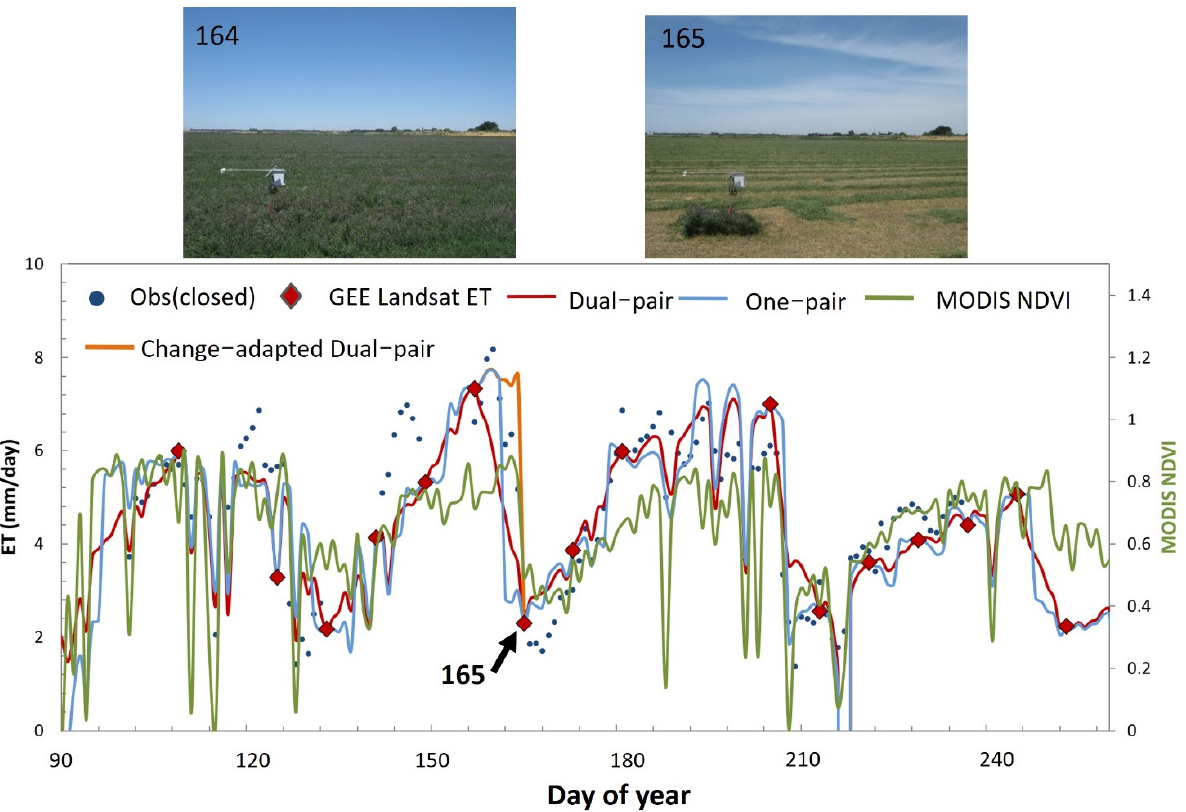
Figure 9. Time series of daily fused ET using different STARFM modes over the growing season of 2014 for US-Tw3 alfalfa site.